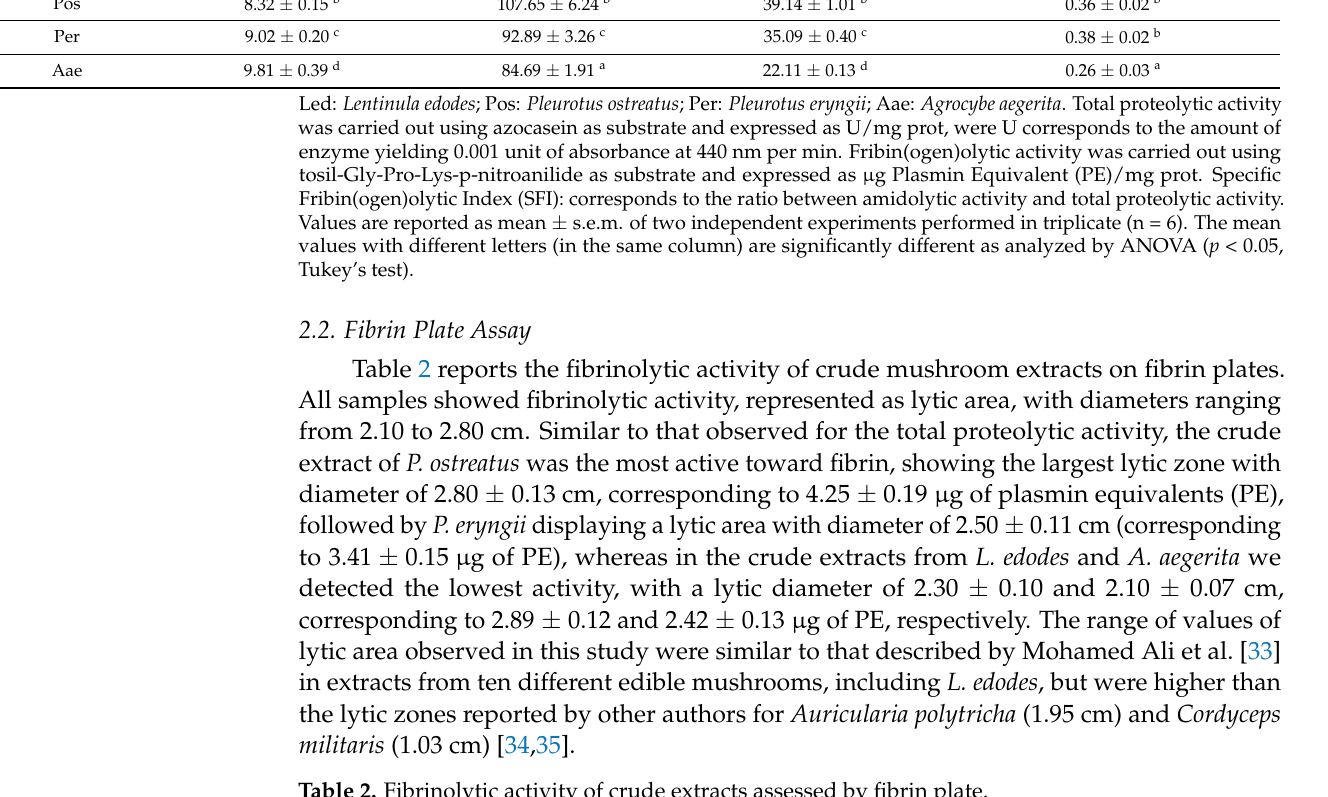
Table 2. Fibrinolytic activity of crude extracts assessed by fibrin